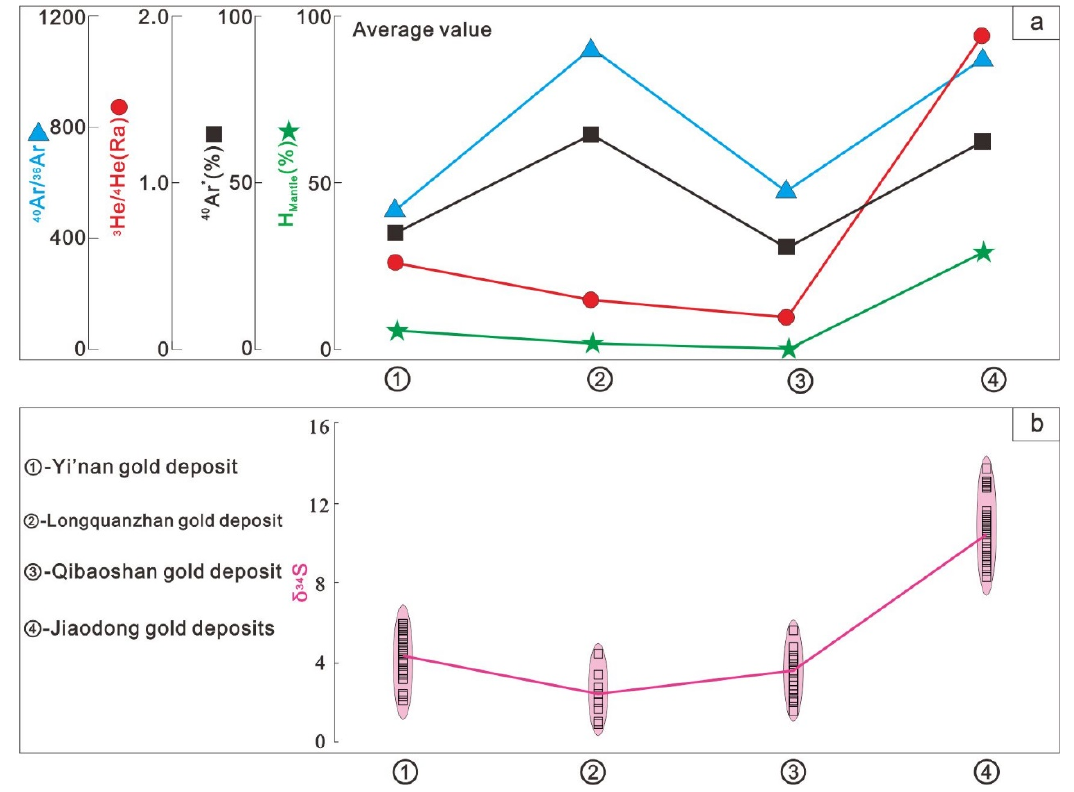
Figure 11. The sulfur, helium, and argon isotopic compositions along the section from the Luxi to Jiaodong gold ore systems. The sulfur isotopic data for the typical gold deposits in the Jiaodong area are from [4,7,48,49].